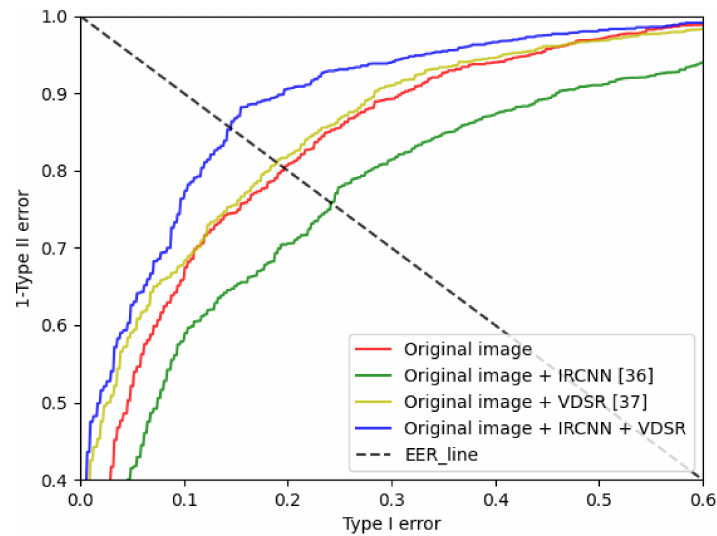
Figure 10. ROC curves of gender recognition accuracies using visible-light